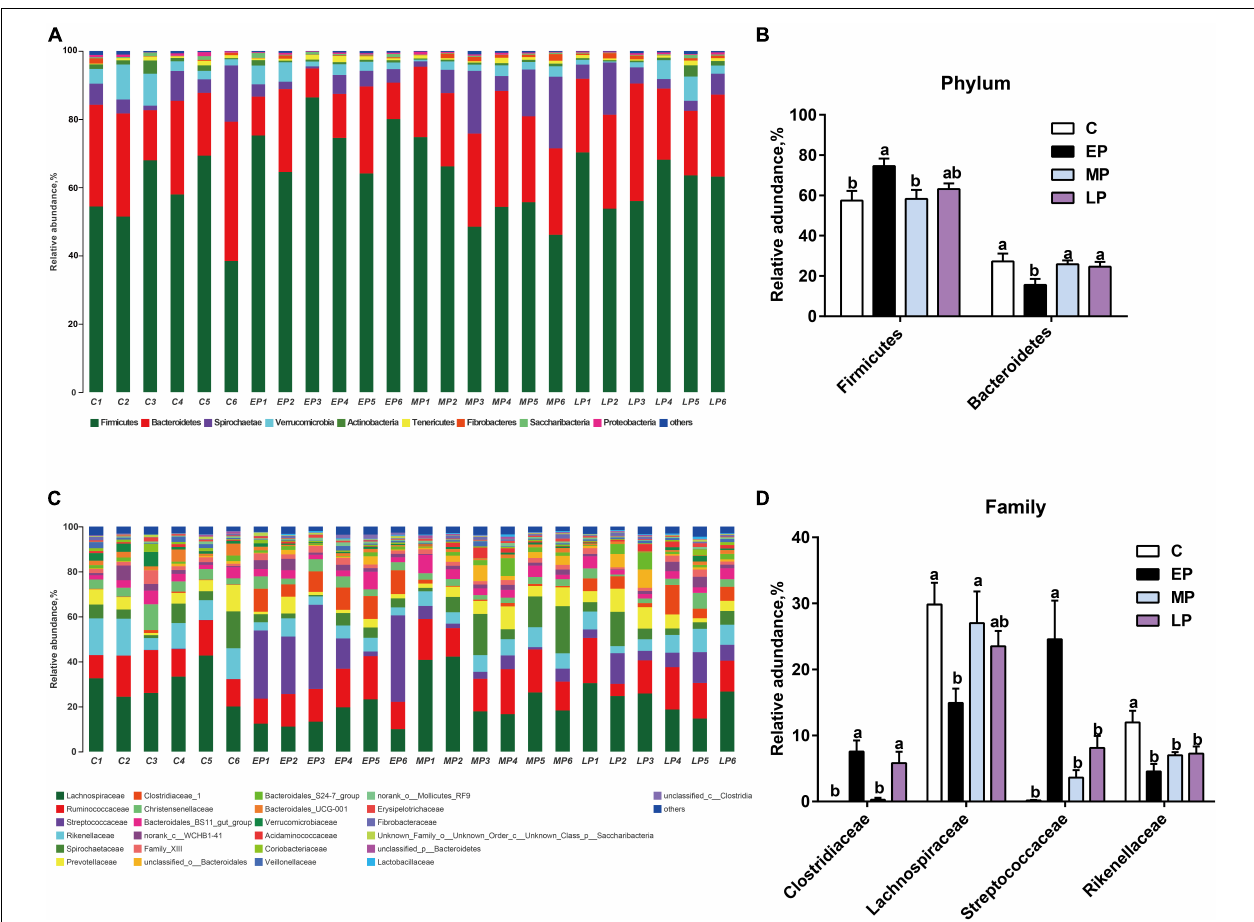
FIGURE 3 | The distinct bacterial composition of the gut microbiota in Dezhou donkeys during different gestation stages. (A) The gut bacterial composition at the phylum level in donkeys during different gestation stages. (B) The relative abundance of the phylum Firmicutes and Bacteroidetes in donkeys during different gestation stages. (C) The gut bacterial composition at the family level in donkeys during different gestation stages. (D) The relative abundances of the families Clostridiaceae, Lachnospiraceae, Streptococcaceae, and Rikenellaceae in donkeys during different gestation stages. C, non-pregnancy as a control; EP, early-stage pregnancy; MP, middle-stage pregnancy; LP, late-stage pregnancy. Data indicate means ± SEM ( n = 6), a , b Means with different letters are significantly different, p <